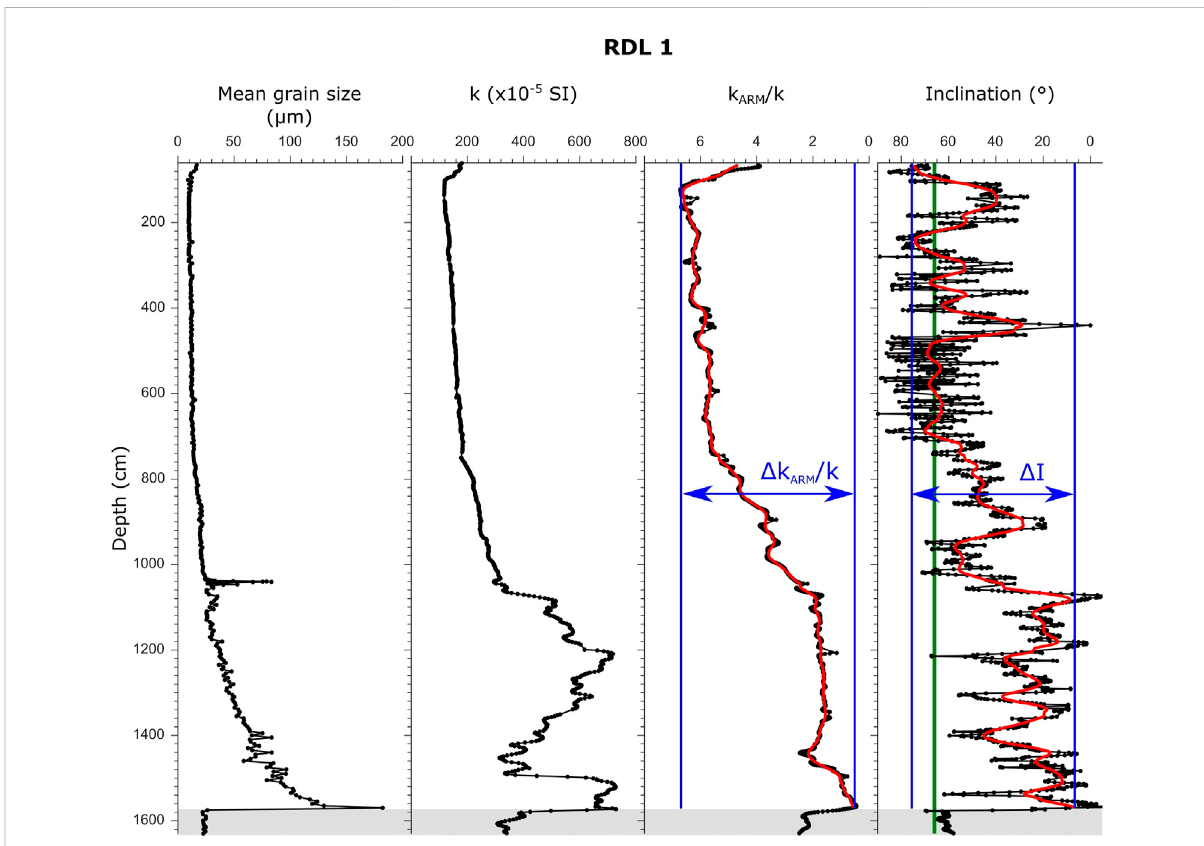
FIGURE 3 SedimentologicalandphysicalpropertiesoftheRDL1eventfromcoreMD99-2222(St-Ongeetal.,2004).Redcurveswereobtainedbysingular spectrumanalysis(SPA).ThemaximumamplitudechangesininclinationsandgrainsizeswerecalculatedfromtheSPAresultsandareshownbyblue arrows. Green line in the inclination represents the geocentric axial dipole (GAD) value. The grey zone represents a normal period of sedimentation before the RDL1